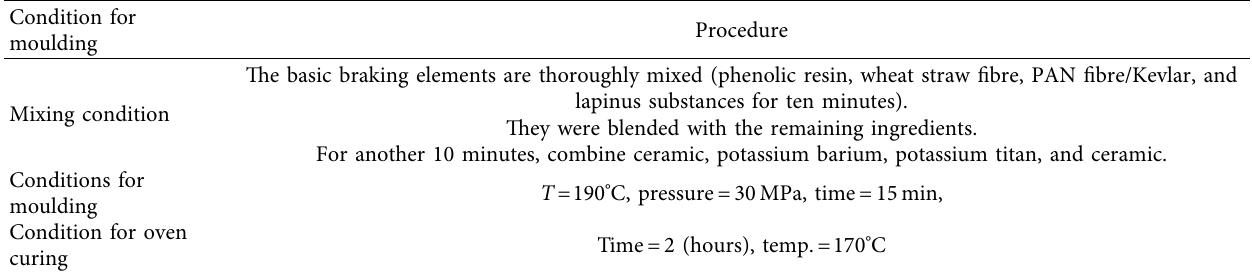
Table 1: Composites fabrication detail.